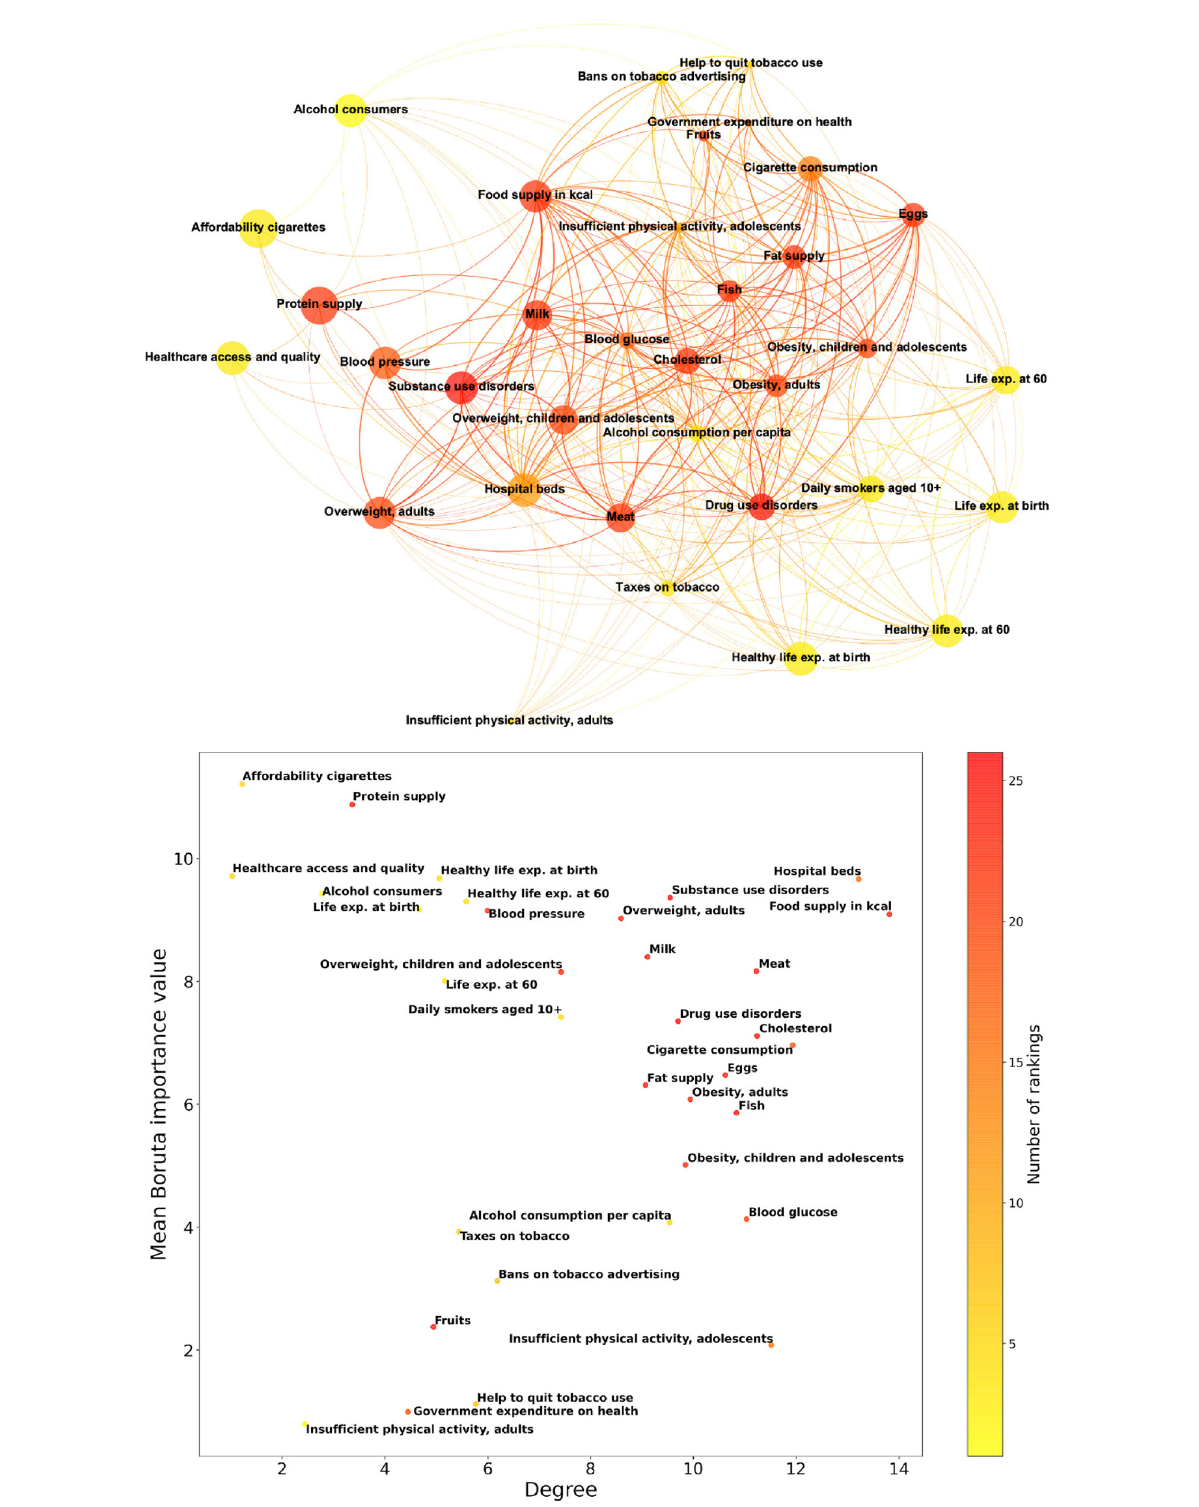
FIGURE3 Properties of the competition network based on the rankings of Boruta feature importance values for different years. The upper panel shows the network structure, consisting of 34 nodes representing features, and 338 weighted edges that quantify the tendency of different features to switch their positions in the importance rankings. The lower panel reports in a scatter plot the network degree of features and their mean Boruta importance values. In both panels, features are colored according to the number of Boruta rankings in which they